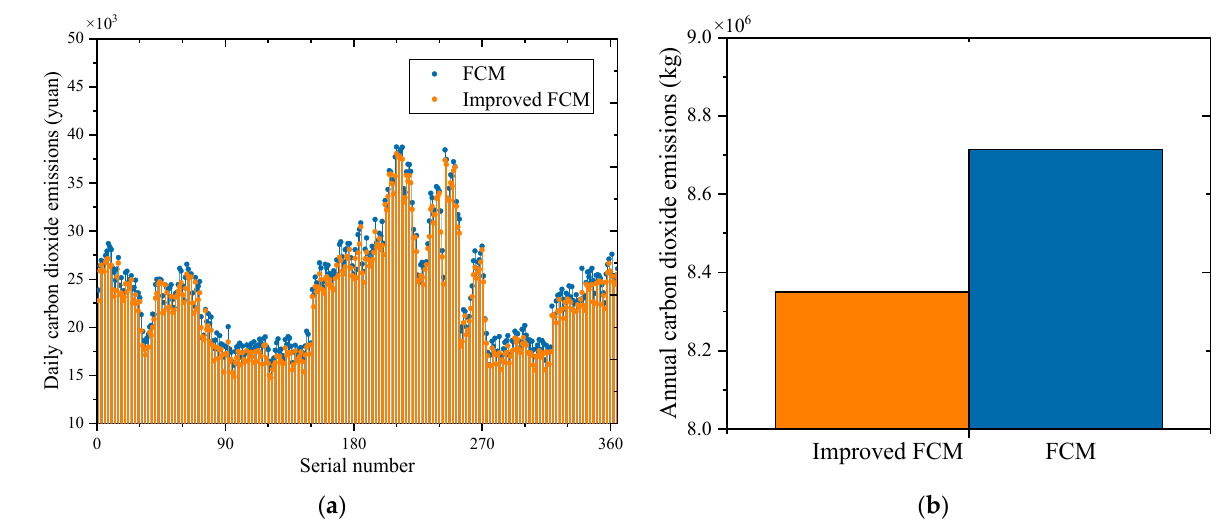
Figure 17. ( a ) Daily carbon dioxide emissions; ( b ) annual carbon dioxide emissions.